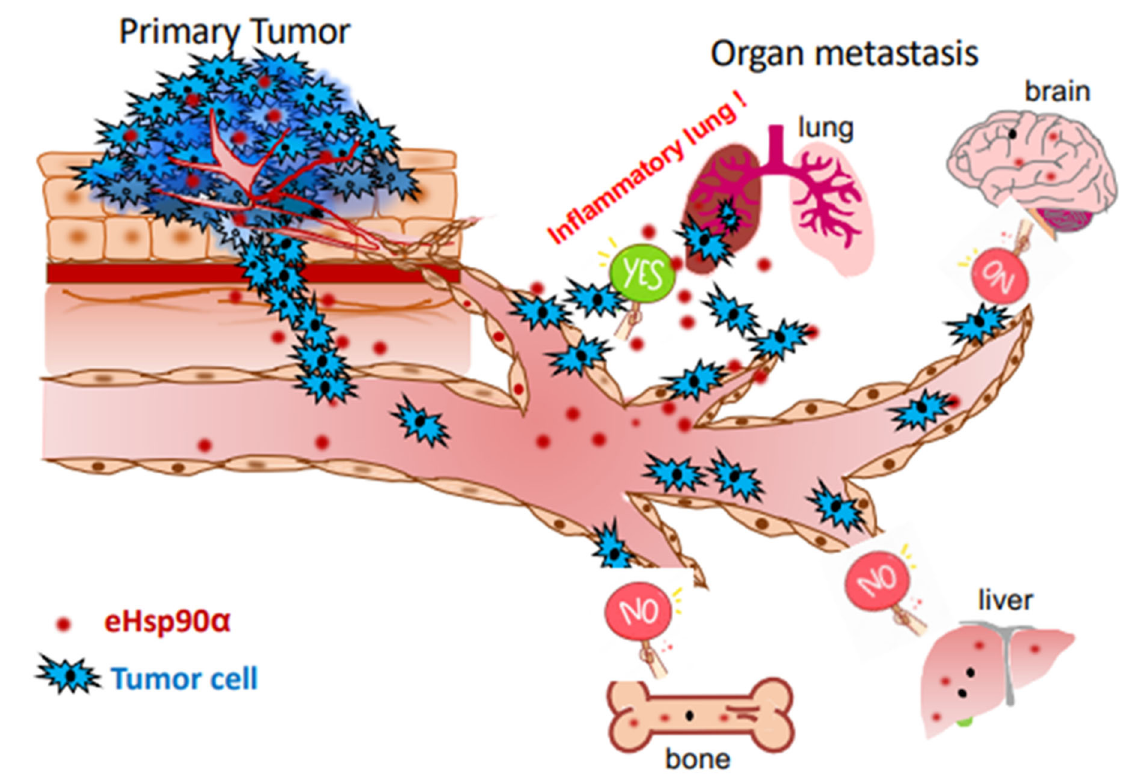
Figure 4. A hypothetical illustration of tumor metastasis being a systemic disease involving tissue inflammation-triggered secretion of eHsp90 α . A primary tumor from the organ of its origin is unable to succeed on metastasis without chronic damage of a distant organ, such as IPF lung. The chronic inflammation of the damaged organ attracts and welcomes circulating tumor cells (CTCs) to their new home. Participation of tissue damage-triggered secretion of eHsp90 α in tumor metastasis has been supported by recent studies.